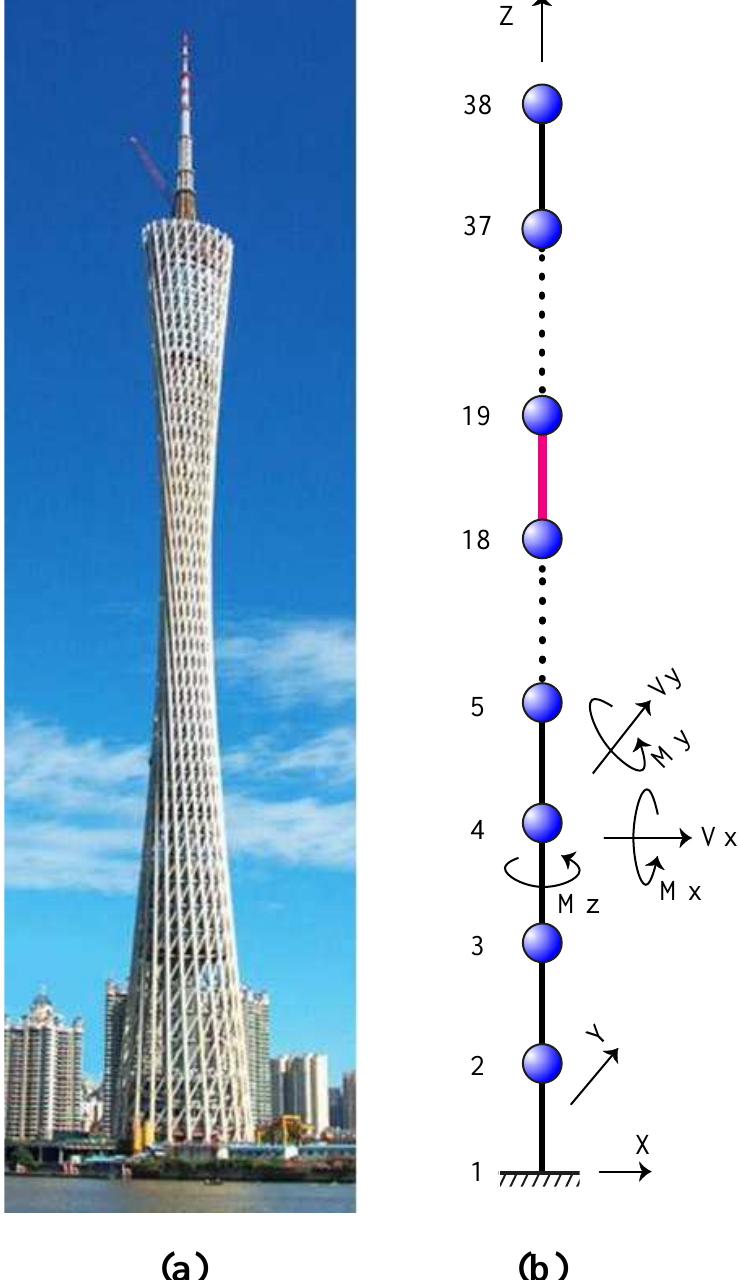
Figure 14. The Canton Tower: ( a ) overview ( b ) reduced-order finite element model.